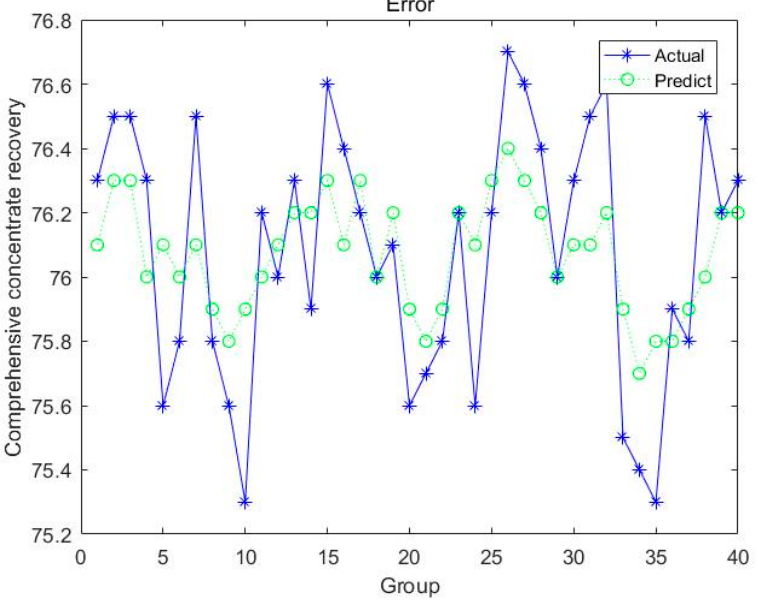
Figure 3. Text of neural network.